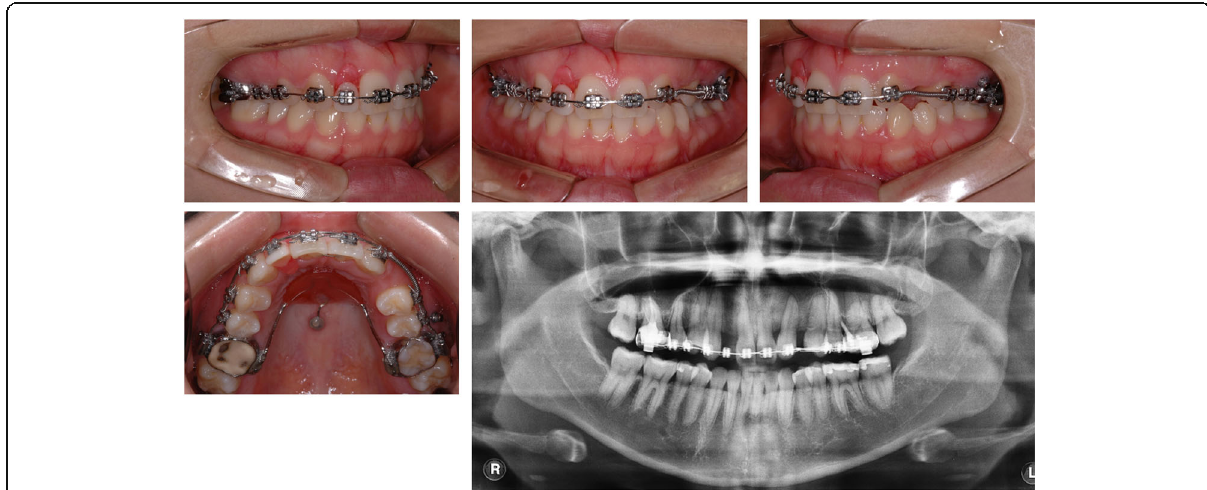
Fig. 2 Intraoral photographs and panoramic radiographs after 9 months of space opening treatment